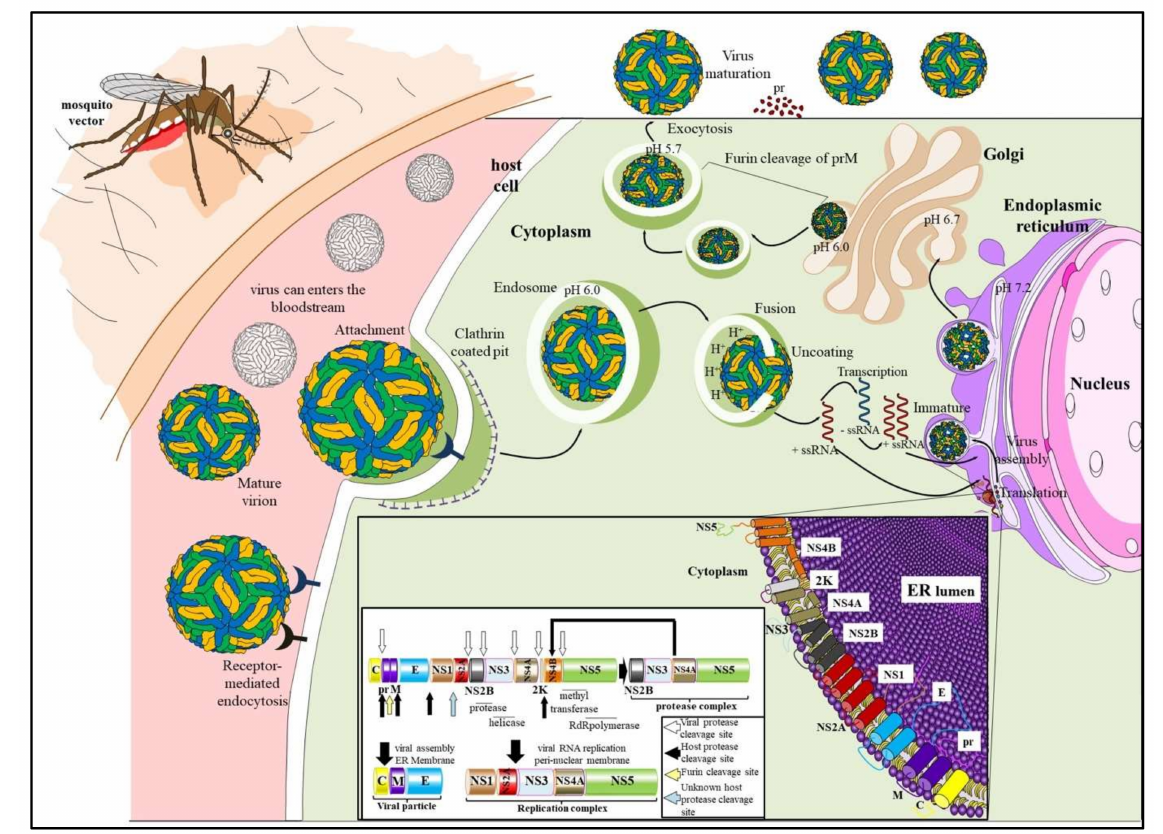
Figure 1. The replication cycle and genome organization of ROCV. The insert in the lower part of the figure shows the genome organization with the cleavage sites of the host and viral proteases of ROCV and the viral polyprotein at the endoplasmic reticulum